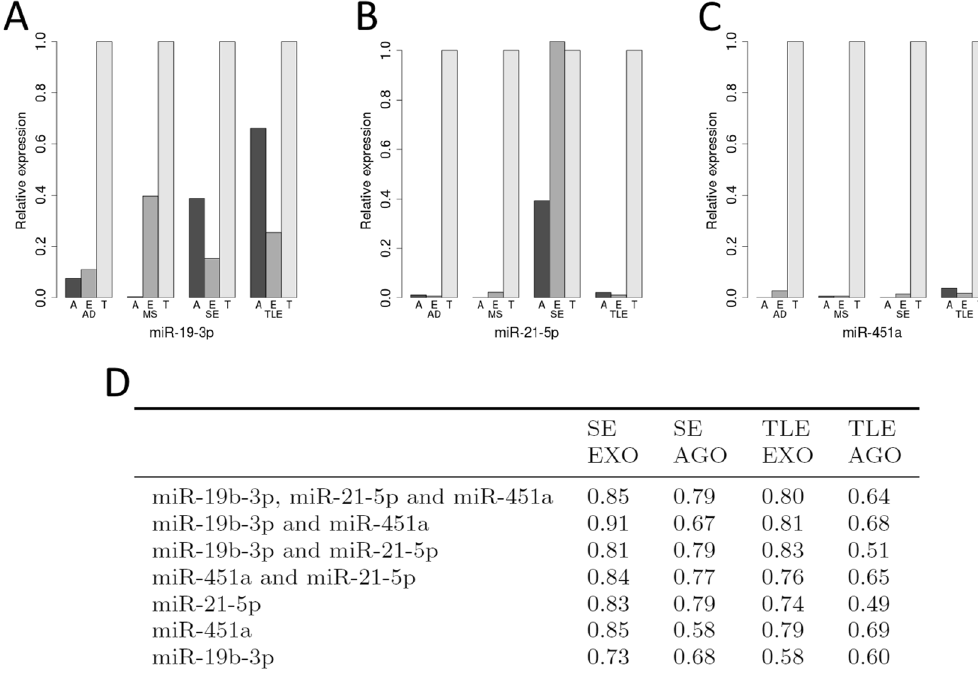
Figure 5. Relative expression of Argonaute2 ( A ), exosome (E) and total (T) microRNA in Alzheimer’s disease (AD), multiple sclerosis (MS), SE and TLE samples. ( D ) AUC following ROC analysis using binomial logistic regression to combine microRNAs for SE samples versus CH, CND and TLE samples, and TLE samples versus CH, CND and SE samples, for Argonaute2 bound microRNA and exosomal